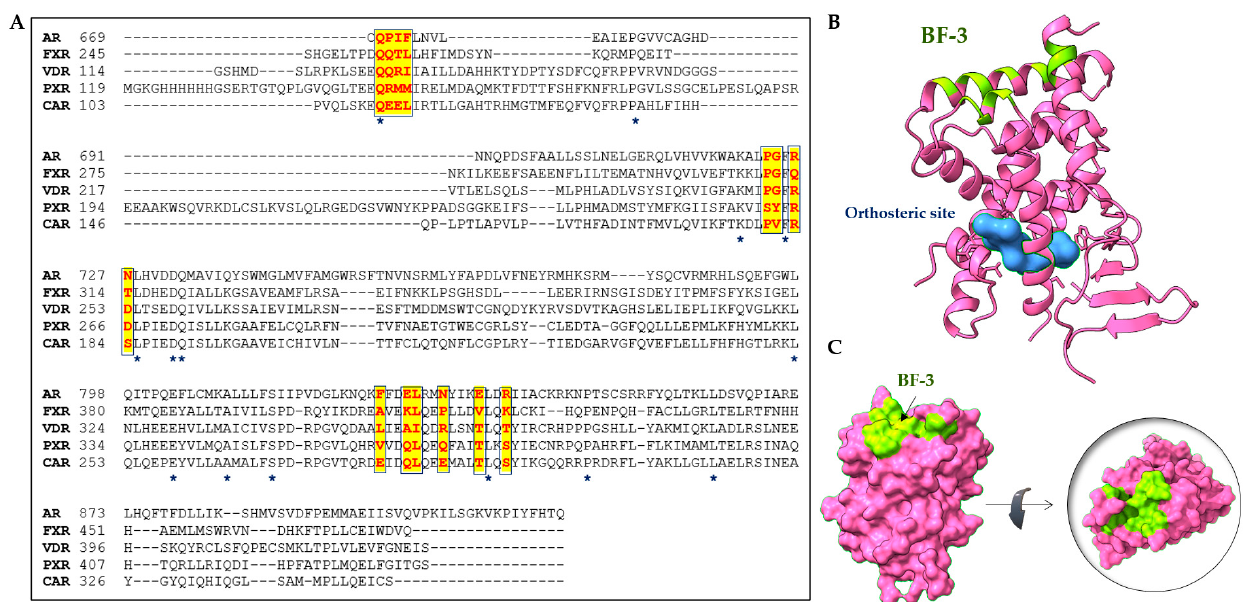
Figure 7. The allosteric binding site BF-3 of the PXR LBD and structural comparisons of the LBD domain between human PXR, CAR, VDR, AR, and FXR receptors. ( A ) Multiple sequence alignment and analysis of PXR, CAR, VDR AR, and FXR receptors show conserved regions. The conserved residues are indicated by the star symbol (*) and the BF-3 residues are highlighted in yellow. This sequence alignment was performed using the Clustal Omega tool (1.2.4) [46,95,97]. ( B ) Crystal structure of the PXR ligand binding domain (pink) showing the ligand binding pocket (blue), and allosteric BF-3 residues are colored green (PDB-5 × 0 R). ( C ) The surface structure of the PXR represents the top view of the BF-3 site (right) and the location of the BF-3 pockets. Structures B and C are in the same orientation.